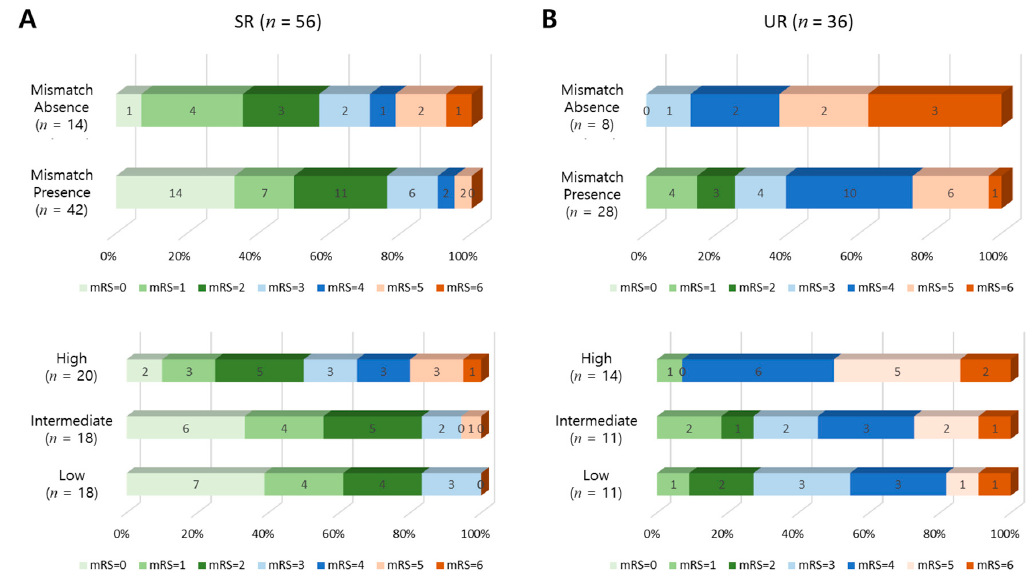
Figure 5. Distribution of modified Rankin Scale (mRS) scores at day-90 by target mismatch (top) and ML-predicted infarct growth (bottom). In both ( A ) SR and ( B ) UR patients, a lower ML-predicted infarct growth was related to a lower mRS score at day 90.